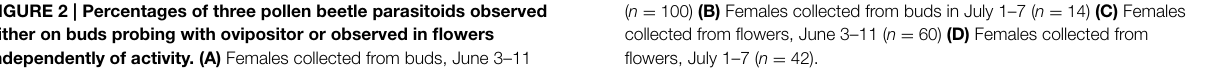
( n = 100 ) (B) Females collected from buds in July 1–7 ( n = 14 ) (C) Females collected from flowers, June 3–11 ( n = 60 ) (D) Females collected from flowers, July 1–7 ( n = 42